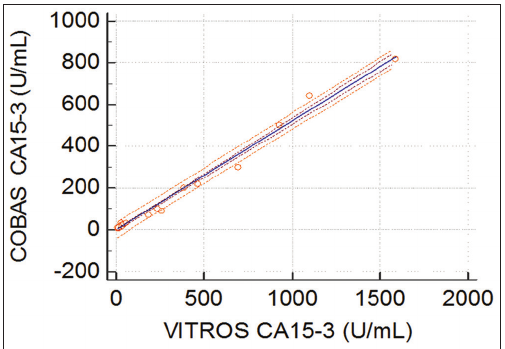
FIGURE 3. Comparison of cancer antigen (CA) 15-3 antigen deter- mined in human serum samples using VITROS 5600 Integrated System and Cobas E 601 analyzer (r = 0.9900 to 0.9971).